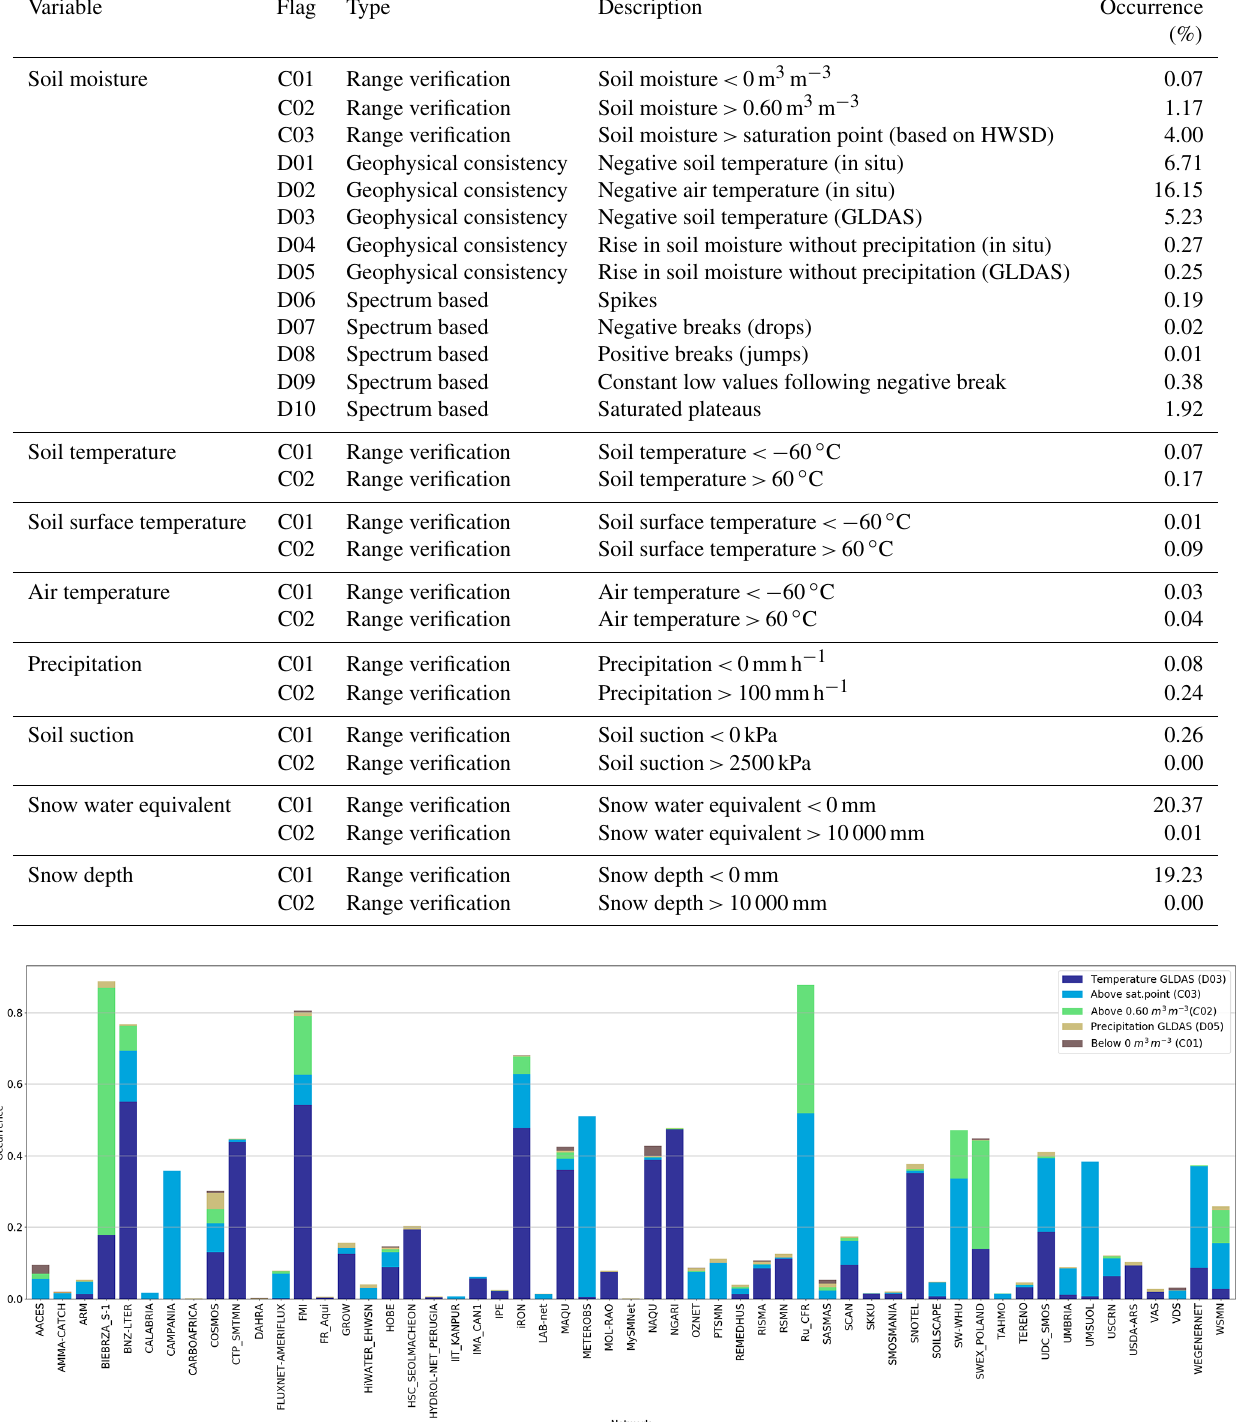
Figure 5. Fractions of geophysical dynamic range and consistency quality flags per network. Note that, in principle, the cumulative sum of fractions can be > 1 as the occurrence of each flag ranges between 0 and